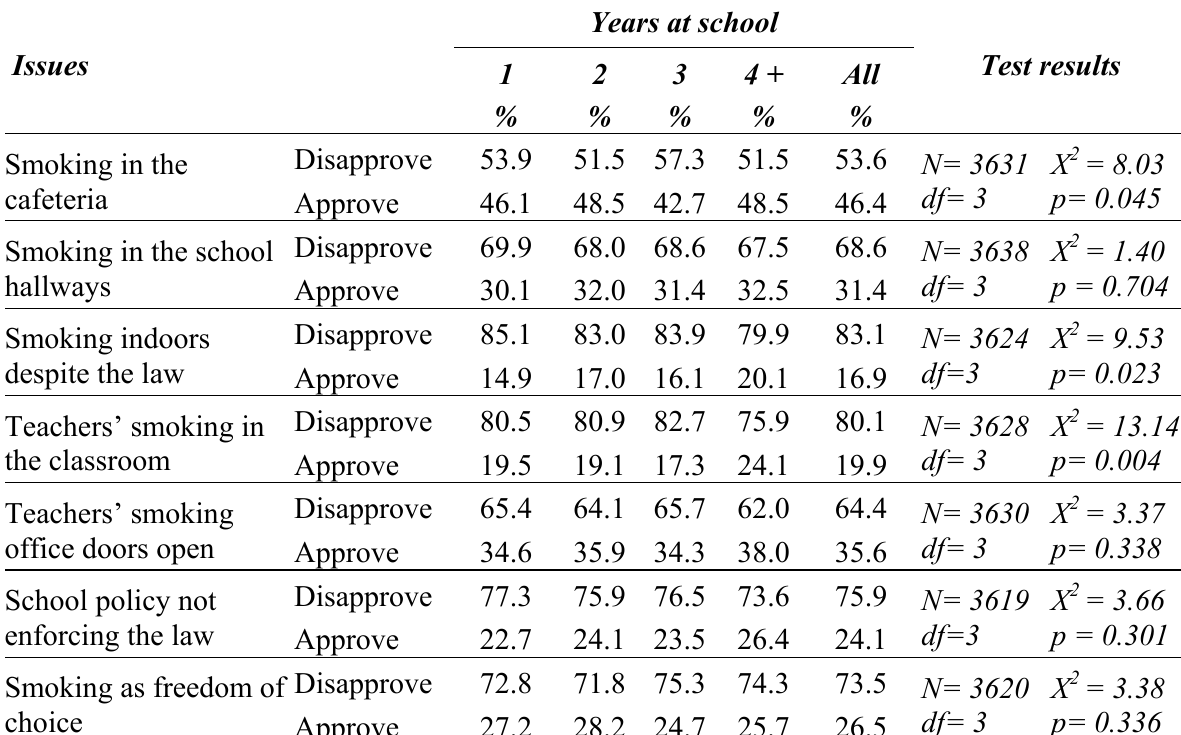
Table 4. Distribution of responses by the school